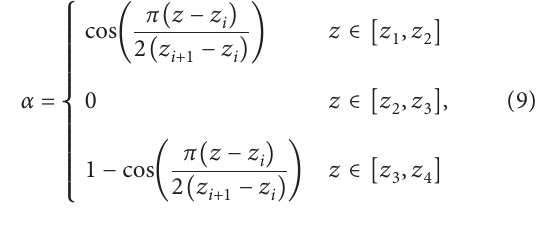
Figure 3: Schematic diagrams of four types of Sandwich FGP